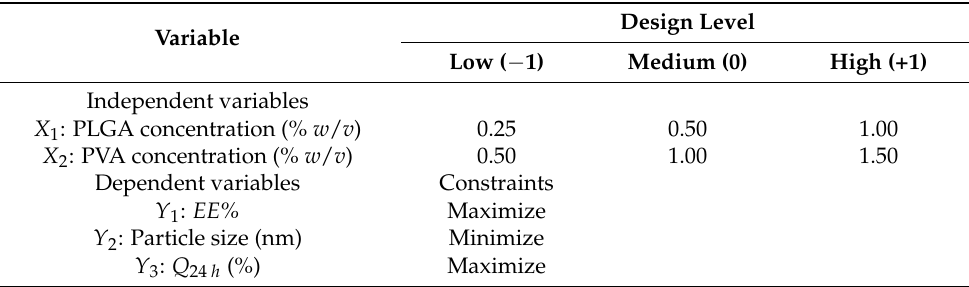
Table 1. The statistical design (3 2 full factorial) parameters elected for optimization of NFD-CTS- PLGA nanocomposites.